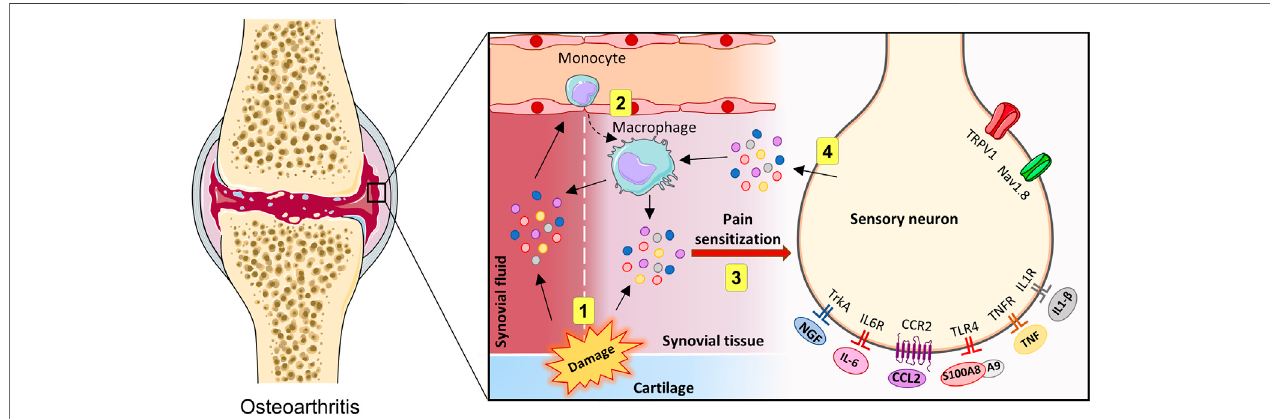
FIGURE 2 | Innate immune activation in the joints and crosstalk with OA pain. Representation of direct and indirect actions of innate immune system activity on sensory neurons in the joints (1 – 4). During OA, tissue injuries accumulated over time may lead to the release of proin fl ammatory mediators, which may trigger a local innate immune system reaction (1). Then, leukocytes can be recruited, which subsequently produce additional proin fl ammatory factors (2). In the knee joint, proin fl ammatory molecules can directly excite sensory afferents neurons (3). Sensory neurons can be activated, resulting in the release of additional in fl ammatory mediators (4). Created with Smart. Servier ®